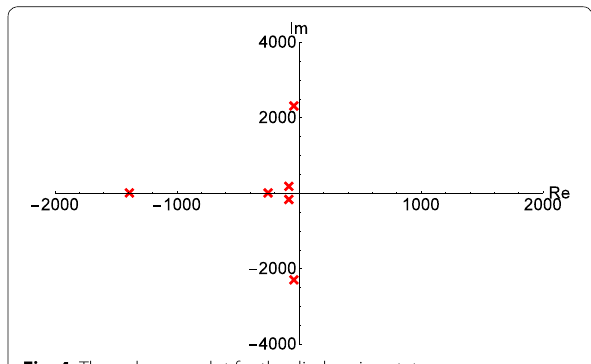
Fig. 4 The pole–zero plot for the discharging properly display the effect of charging and discharging. The source converter responses are shown in Fig. 5a–d.